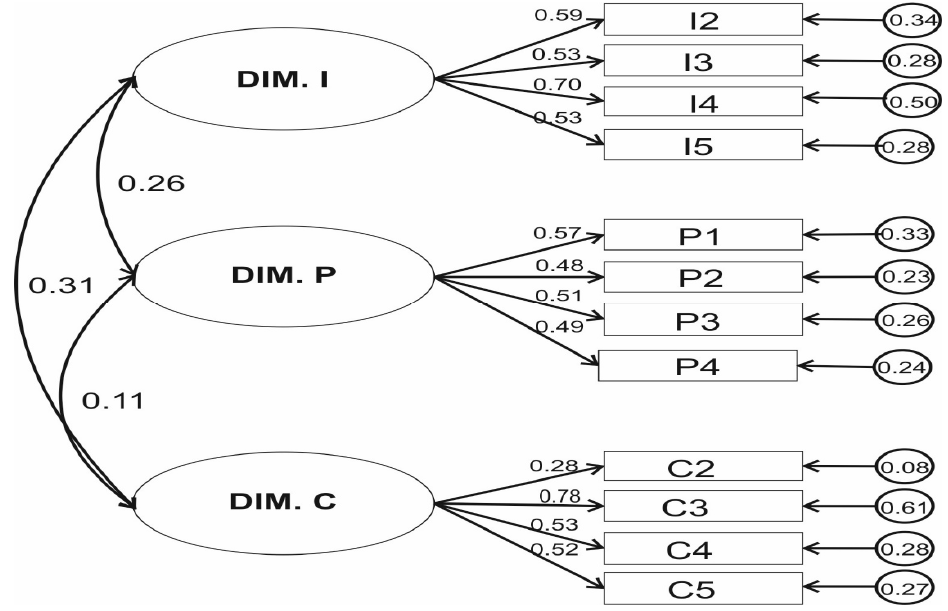
Figure A1. Model CFA.